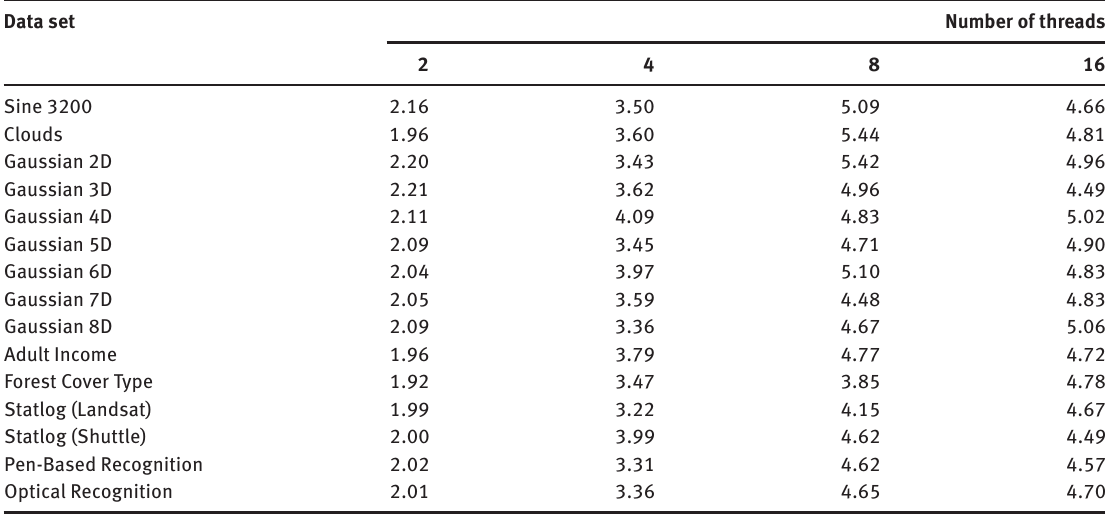
Table 5: Speedup Factors of the Parallel AMCOV Generation Algorithm over the Serial AMCOV Generation Algorithm. Data